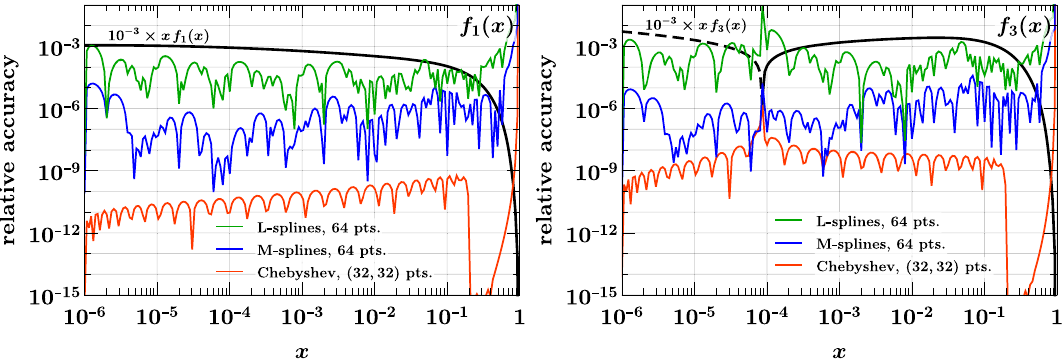
Fig. 1 Relative interpolation accuracy (38) for the sample PDFs f 1 ( x ) and f 3 ( x ) in Eq. (37). The spline interpolants (green and blue) use the low-densitygridwith n pts = 64.TheChebyshevinterpolation(red)uses